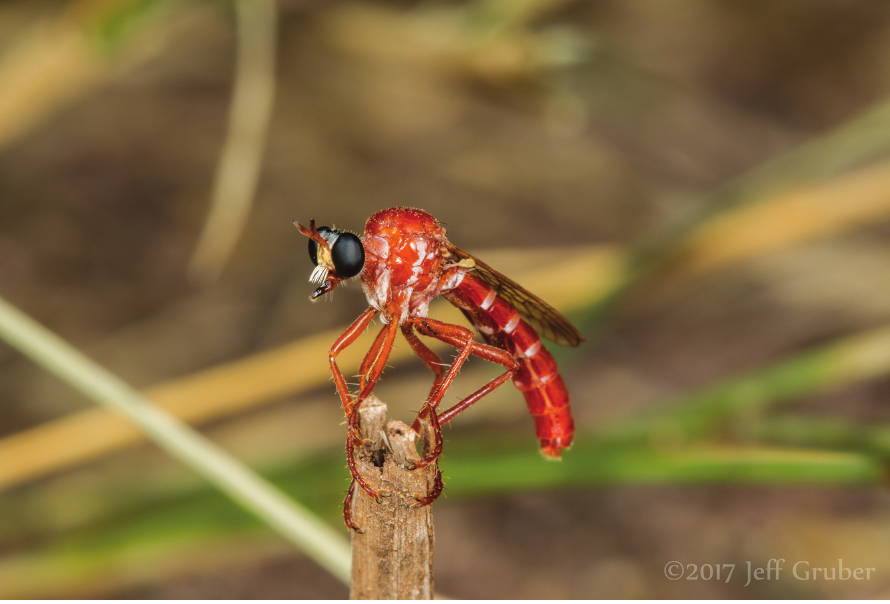
Figure 1. Saropogon pyrodes sp. nov. male in nature at ~0.7 km ENE of Amado in southern Arizo- na on Sep. 5, 2017 (flicker: [https://www.flickr.com/photos/7432824@N07/45297662671/in/al- bum-72157687317436870/]). Photograph by Jeff